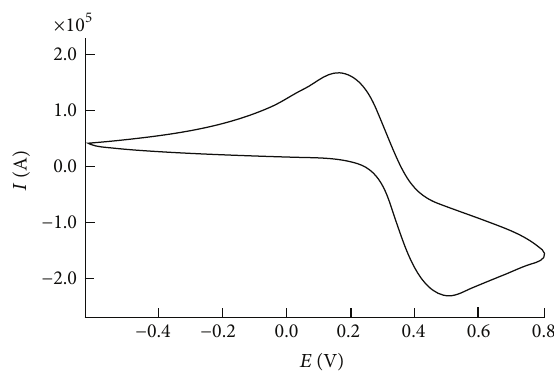
Figure 3: Cyclic voltammogram for 7 at scan rate of 0.02 Vs −1 .